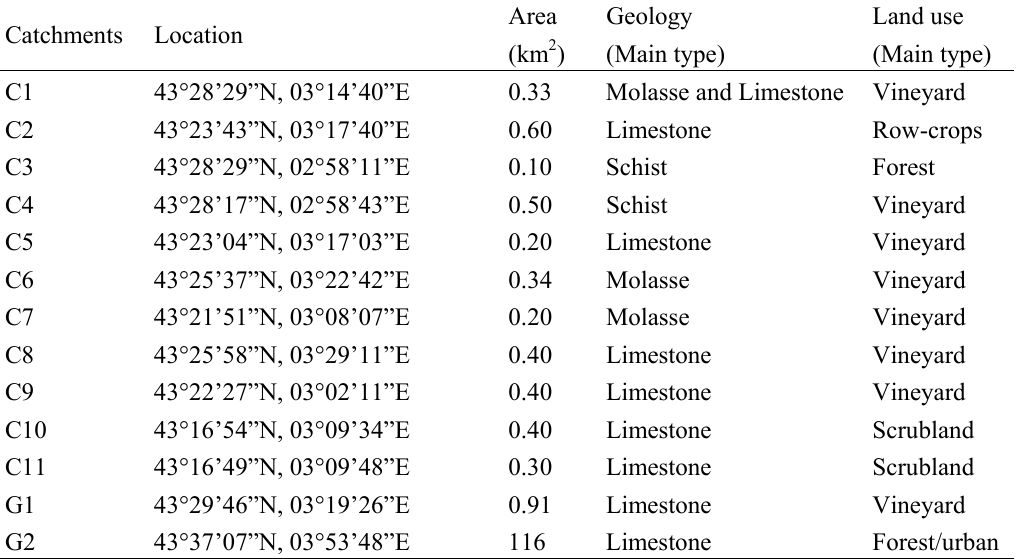
Table 1. Catchment